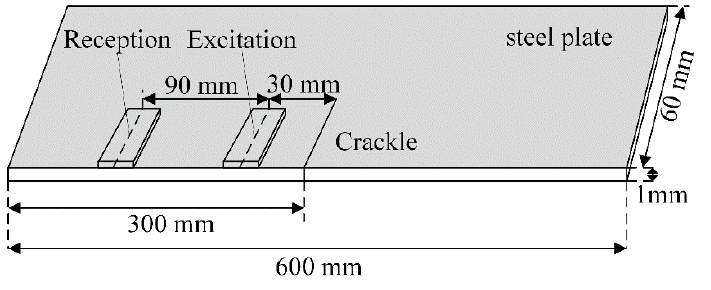
Figure 14. Steel plate defect detection.